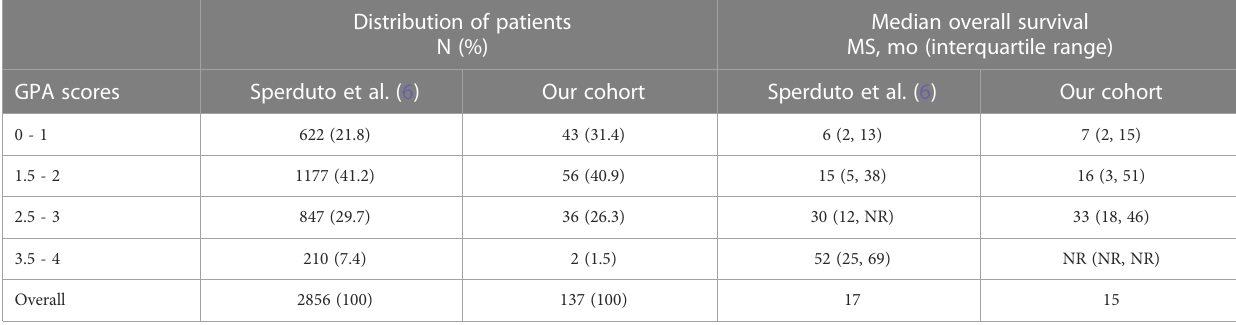
TABLE 2 Comparison of the distribution of patients and median OS of the original cohort and our cohort. Distribution of patients N